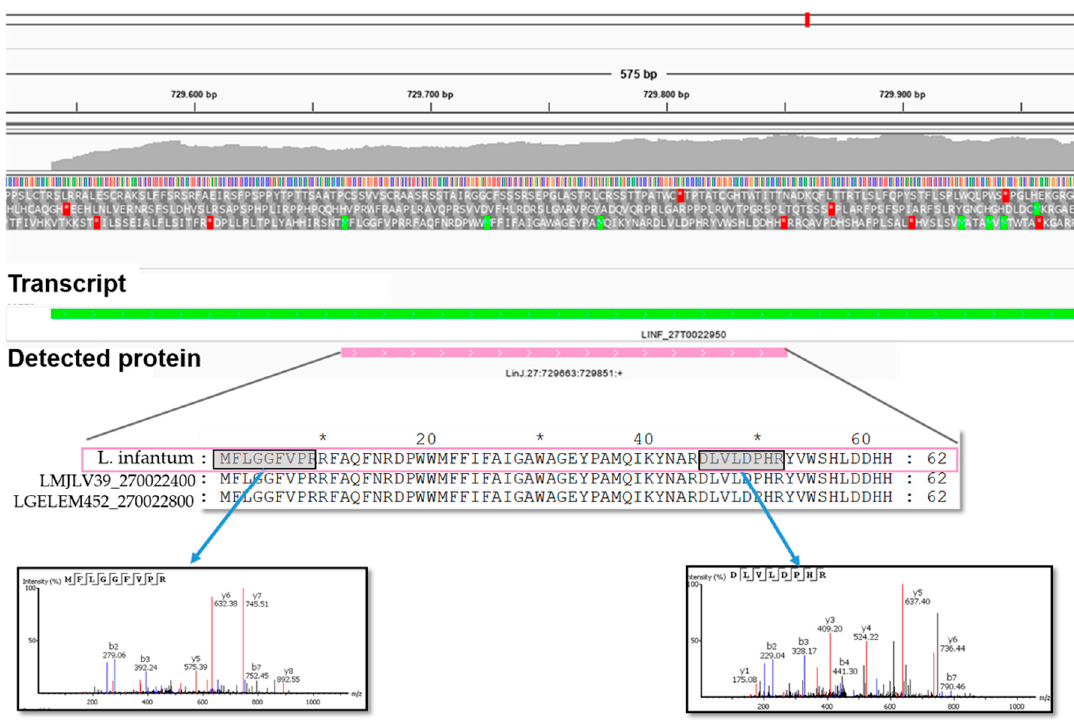
Figure 6. Identification of a novel protein based on the mapping of two experimentally detected-peptides in a region of L. infantum JPCM5 chromosome 27, which currently lacks an annotated ORF. The new CDS, named LINF_ 270,022,950 (pink box), fit well within a predicted transcript (LINF_27T0022950; green box). Interestingly, the predicted amino acid sequence was well-conserved when compared with proteins annotated in the genomic assemblies of L. major LV39 (ID: LmjVL39_270022400) and Leishmania gerbilli LEM452 (ID: LGELEM452_270022800).